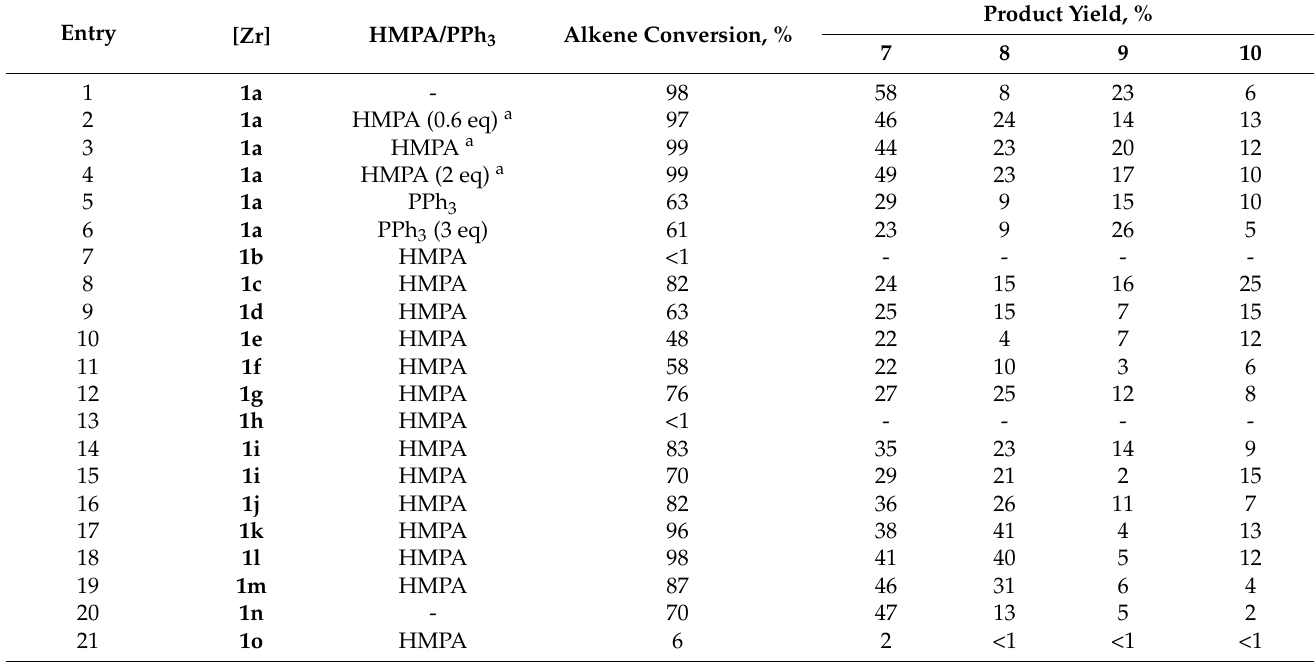
Table 1. Reaction of allylbenzene with EtAlCl 2 and Mg, catalyzed by Zr complexes 1a – o (22 ◦ C, 72